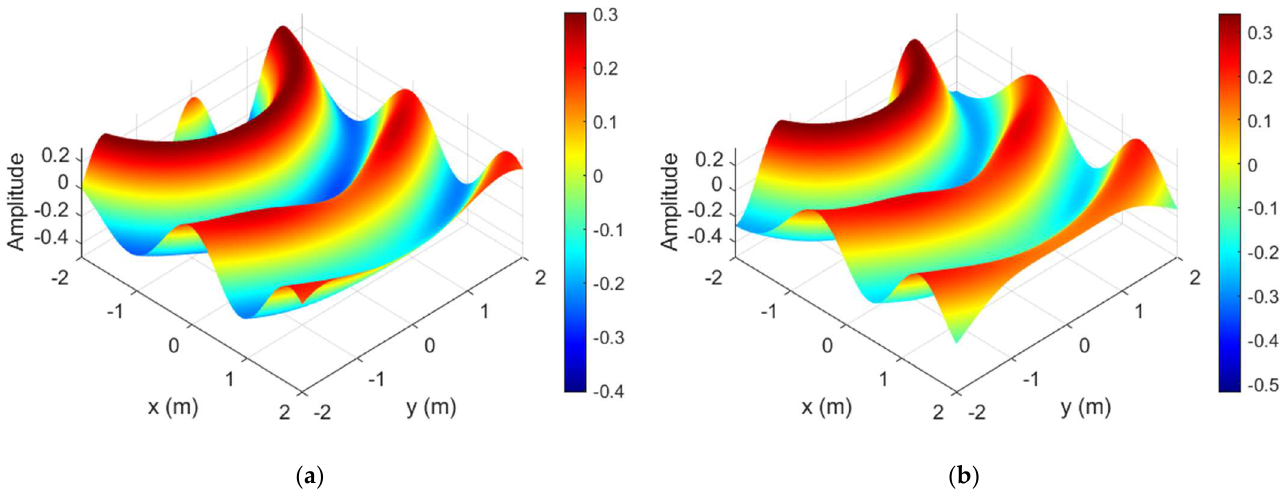
Figure 7. Analytical responses in the domain [ − 2,2 ] × [ − 2,2 ] : ( a ) real part, ( b ) imaginary part.